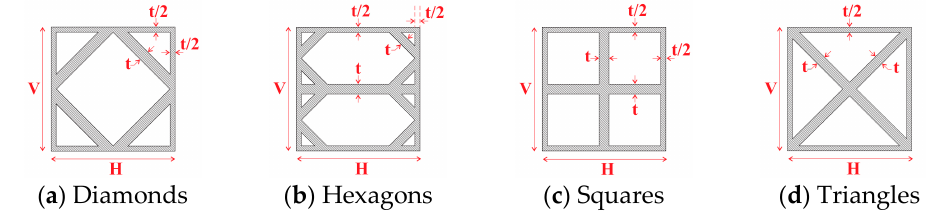
Figure 3. Considered perforation pattern shapes, including the geometric parameters.